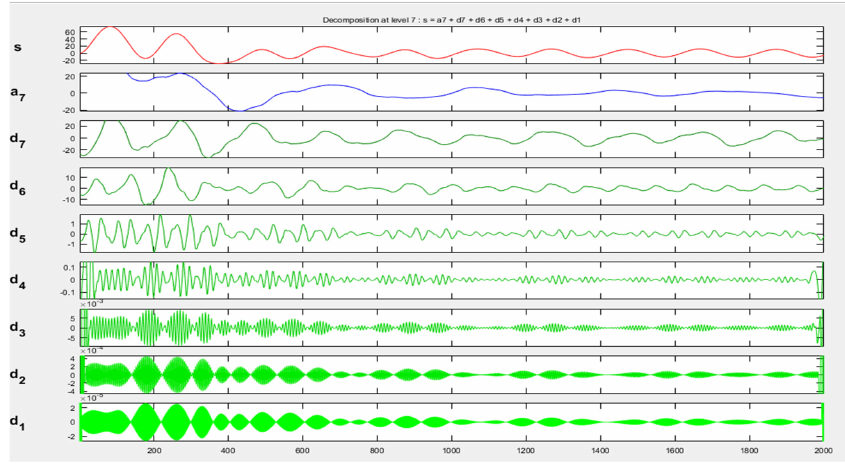
Figure 6. Representation of DWT Approximation Coefficients and Detail Coefficients of Healthy Phase-A Currents with 2000 samples.